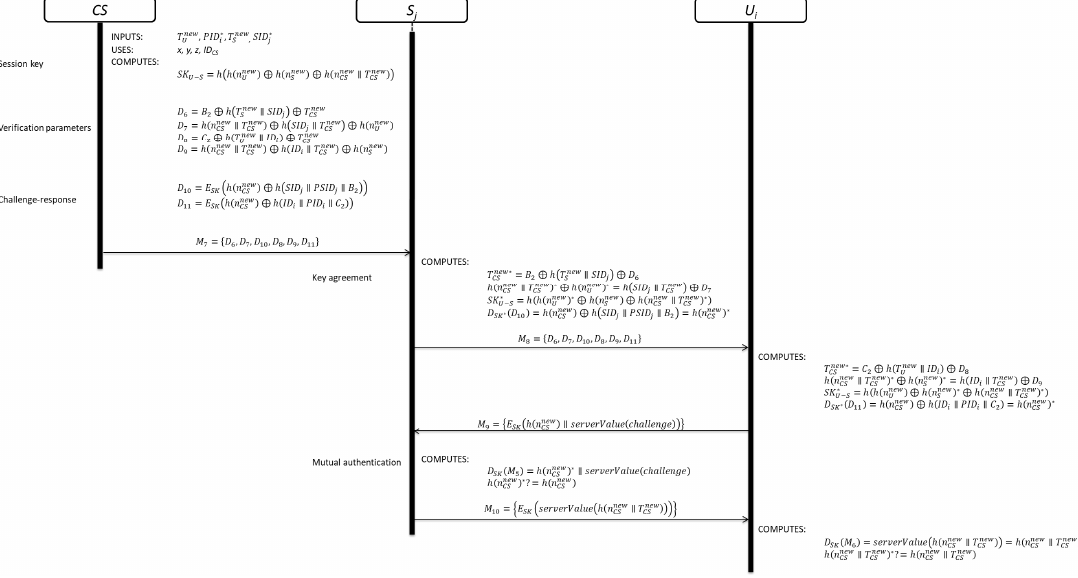
Figure 6. Key agreement and mutual authentication phases.